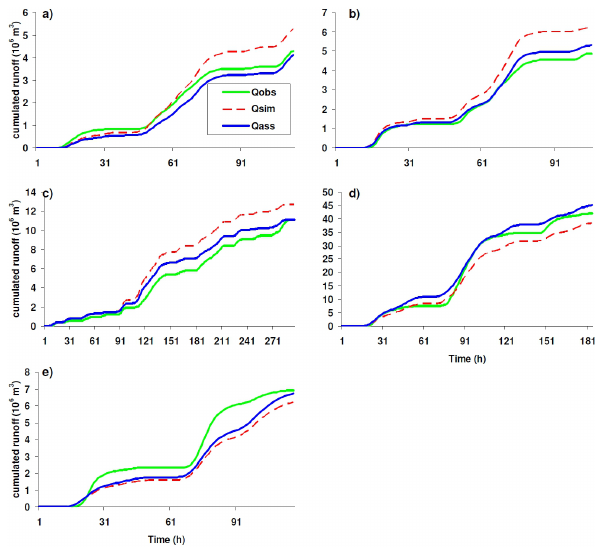
Fig. 5. – Cumulated runoff for the observed and simulated data with and without ASCAT SWI ∗ assimilation for: (a) NIC, (b) ASS, (c) CHI, (d) TEV and (e) TIM